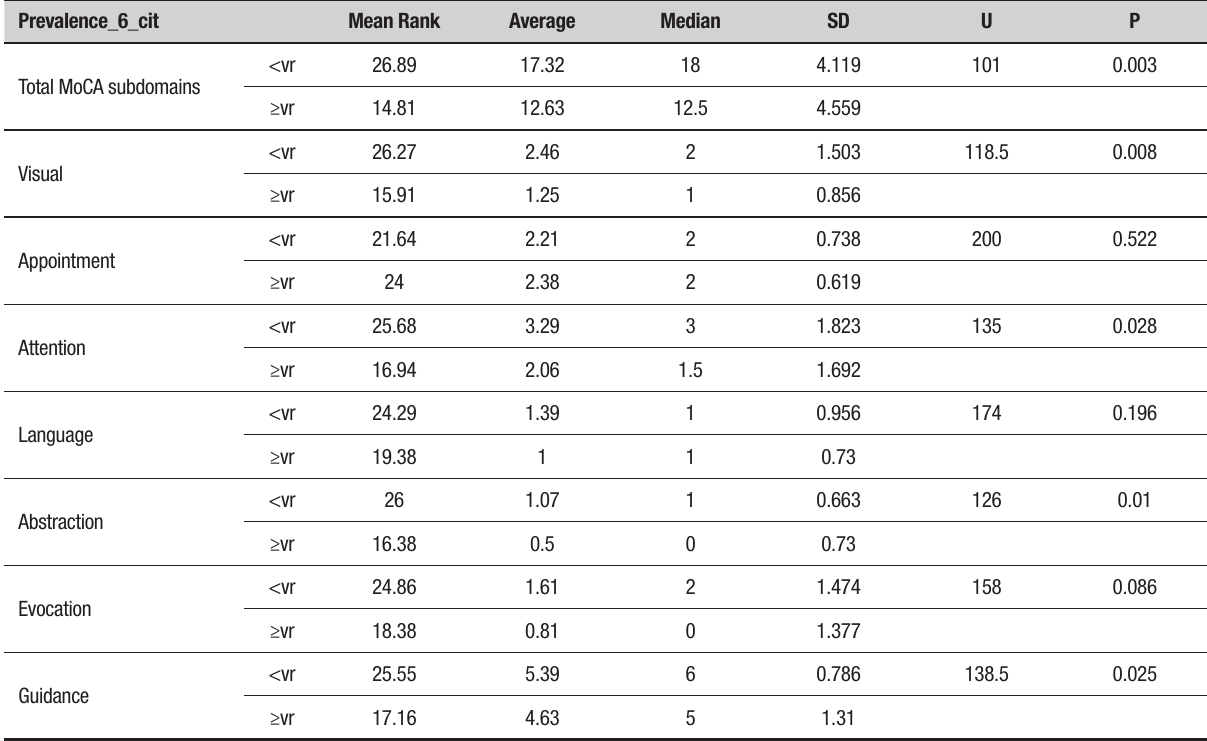
Table 3. Results of the application of the Mann Whitney U test in the Cognitive Assessment variable and its dimensions by group of individuals with and without MDI.